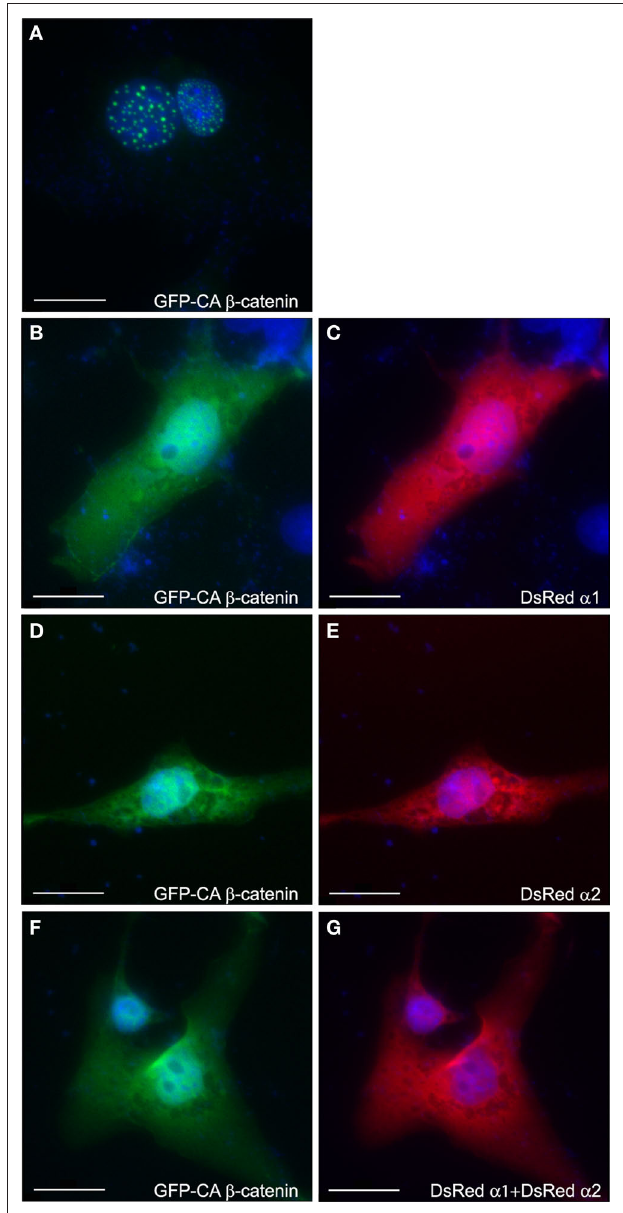
FIgure 4 | PAFAH subunits affect subcellular localization of gFP-CA β -catenin. COS-7 cells were transfected with GFP-CA β -catenin (A) alone or together with DsRed α 1 (B,C) or DsRed α 2 (D,e) , or both PAF-AH catalytic subunits (F,g) . Cells were fixed 48 h after transfection and nuclear DNA was stained with DAPI (shown in blue). Overexpression of GFP-CA β -catenin demonstrated nuclear localization (A) , whereas the addition of either DsRed α 1 (C) or DsRed α 2 (e) or both (g) shifted β -catenin to the cytoplasm (B,D,F) . Scale bars are 20